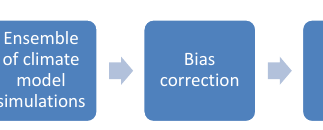
Figure 1. A scheme of the applied modelling